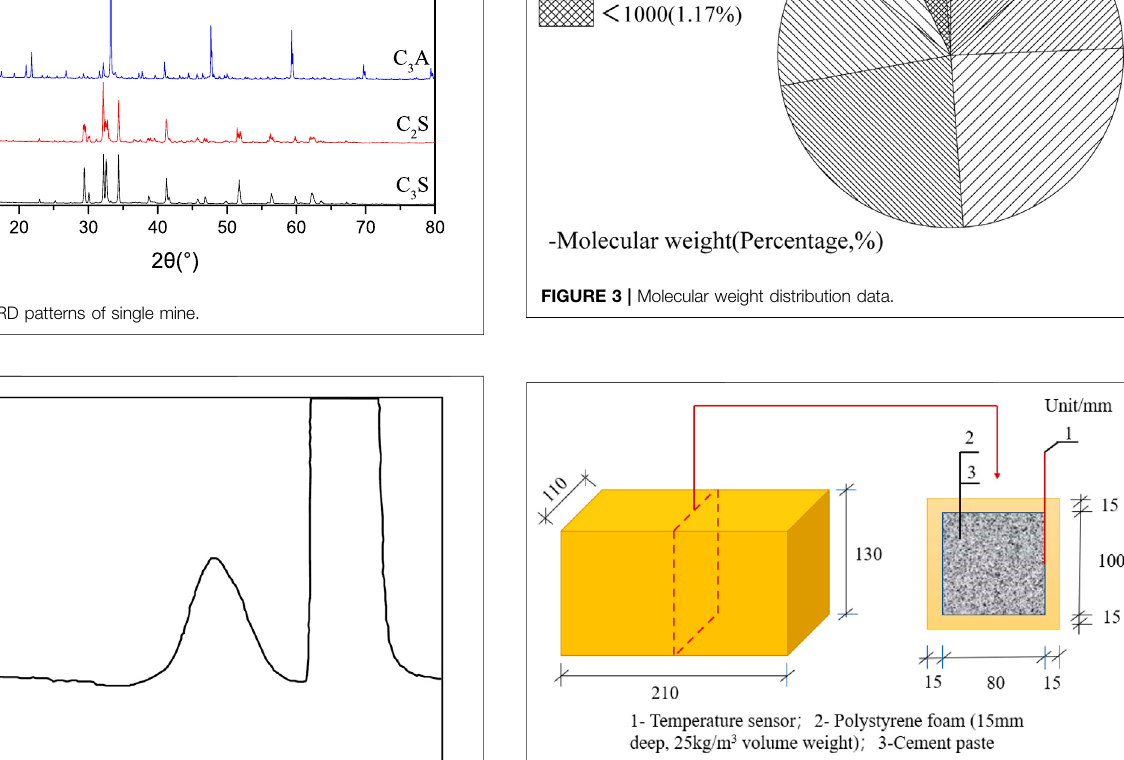
FIGURE 4 | Semi-adiabatic temperature rise test device.